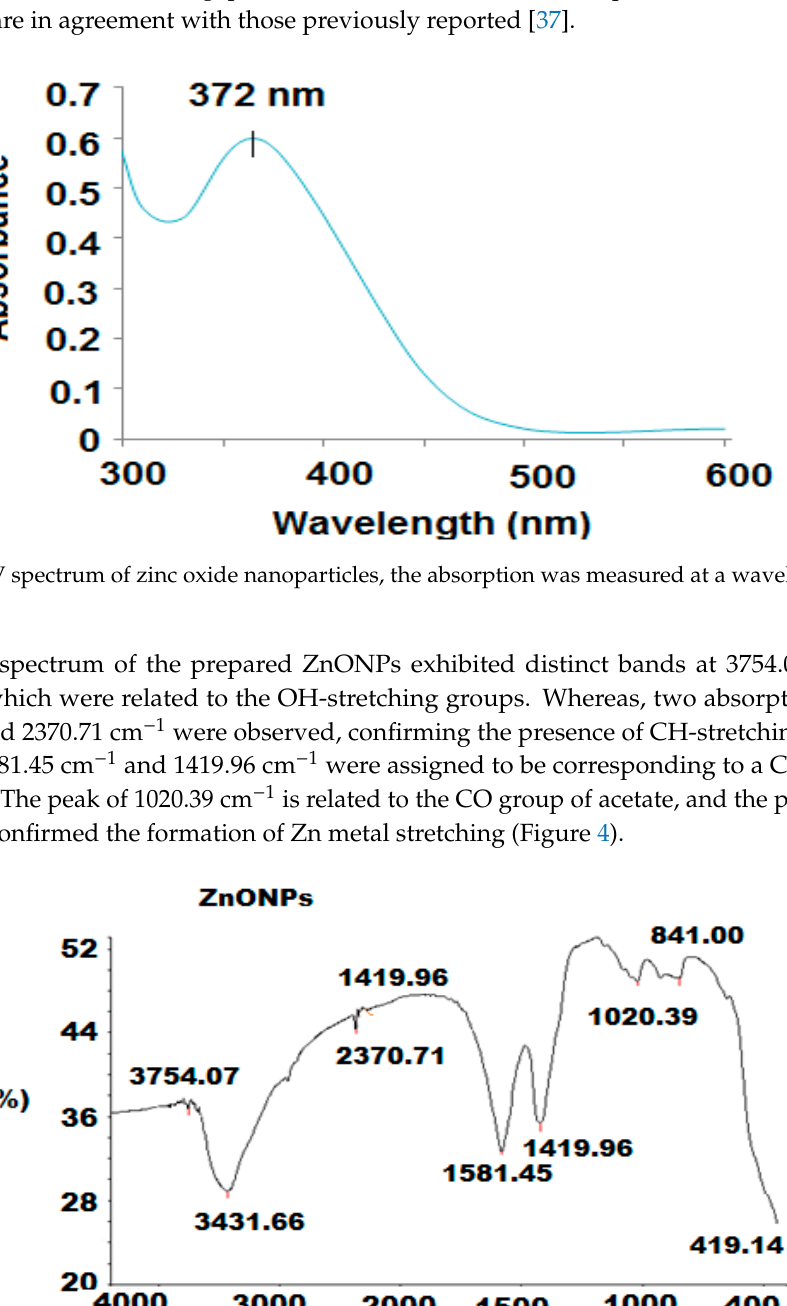
Figure 3. UV spectrum of zinc oxide nanoparticles, the absorption was measured at a wavelength of 200–600 nm.